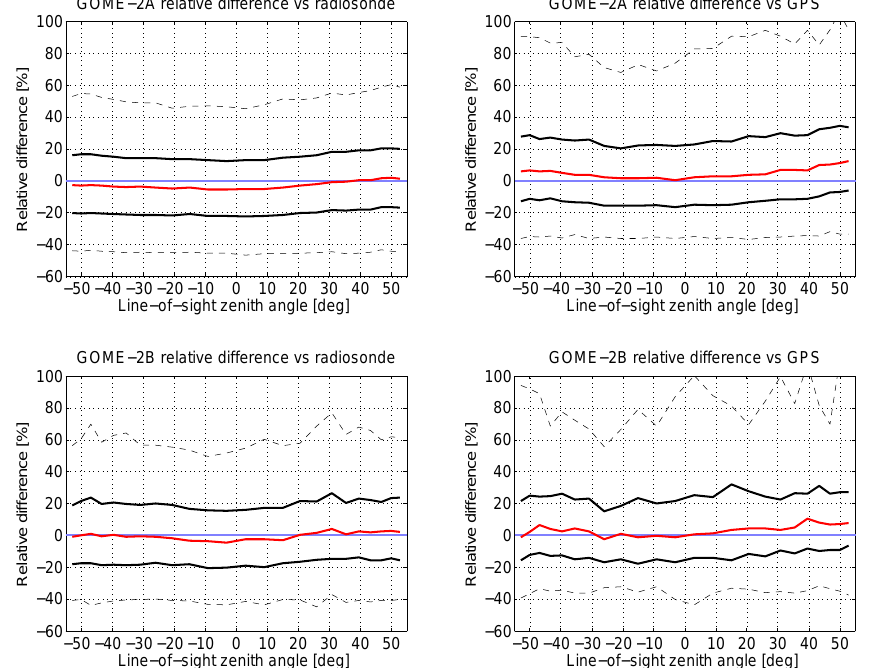
Figure 5. Median relative differences (red solid line), 25 and 75% percentiles (black solid lines) and 5 and 95% percentiles (dashed lines) for GOME-2A (top) and GOME-2B (bottom) against radiosonde (left) and GPS (right) as a function of line-of-sight zenith angle at the centre of the GOME-2 pixel. Negative angles correspond to the eastern edge of the swath and positive to the western. Only observations from full-swath (1920km) scans are used in analysis. Table 2. Statistics of comparisons between GOME-2A with radiosondes over different surface types correlation mean mean relative standard